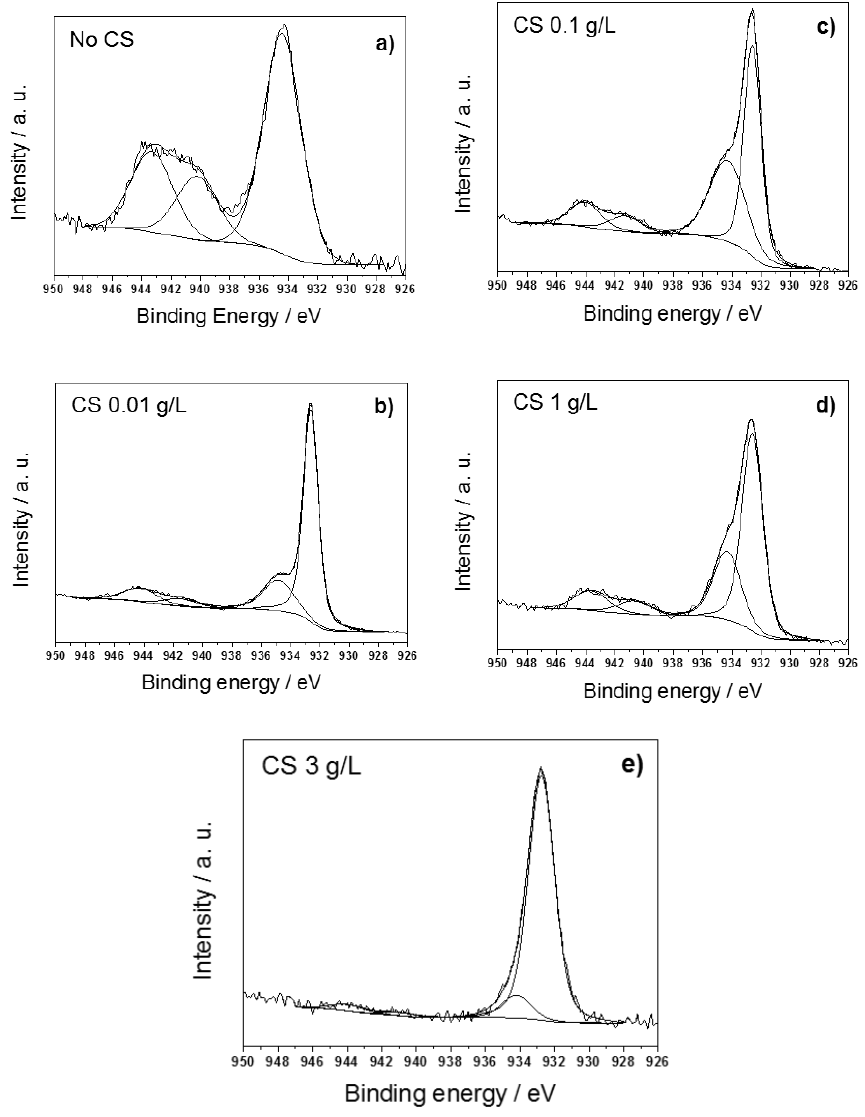
Figure 4. Cu2p 3/2 high-resolution regions of freshly-prepared CuNPs-CS nanocomposites synthetized at CS concentrations of: ( a ) no CS; ( b ) 0.01 g/L; ( c ) 0.1 g/L; ( d ) 1 g/L; ( e ) 3 g/L.